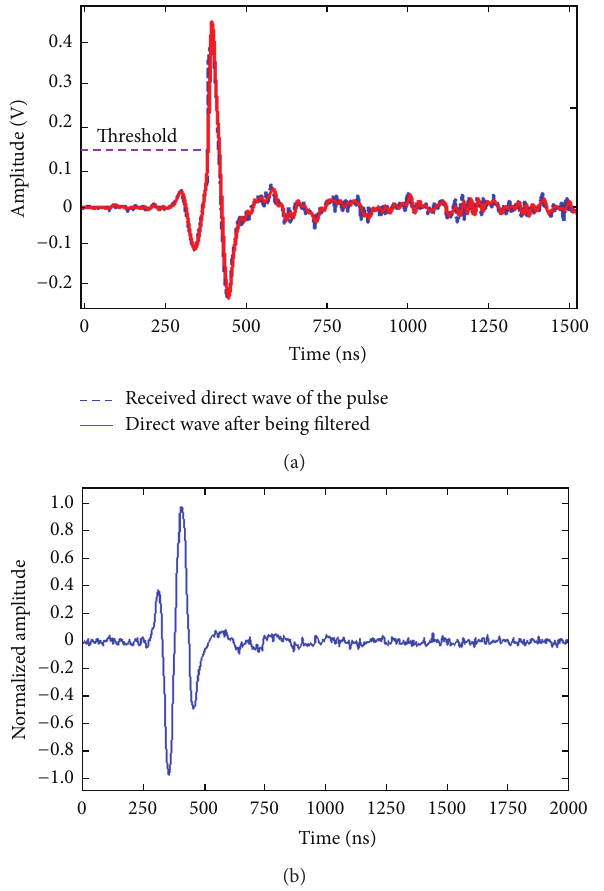
Figure 8: Received synchronization preamble. (a) The direct wave of the monocycle. (b) The cross-correlation of the direct wave of the 𝑚 -sequence with 31 chips.